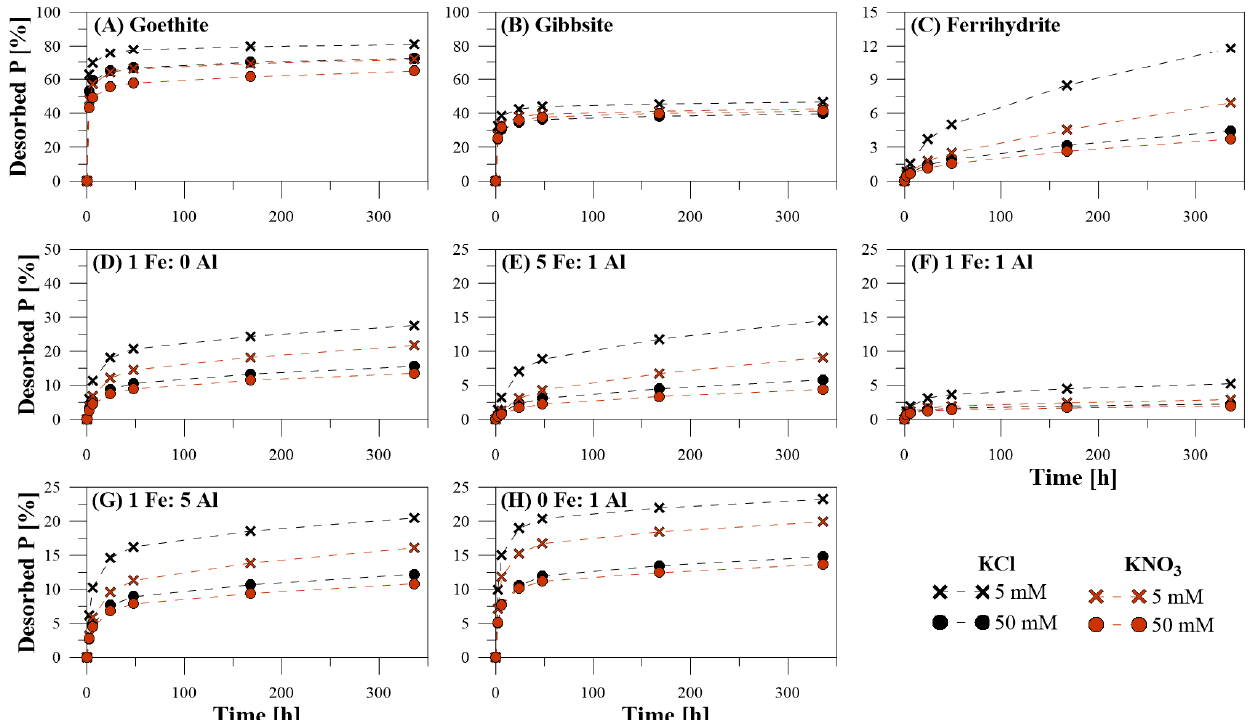
Figure 1. Kinetics of P desorption from ( A ) goethite, ( B ) gibbsite, ( C ) ferrihydrite, ( D ) 1 Fe: 0 Al, ( E ) 5 Fe: 1 Al, ( F ) 1 Fe: 1 Al, ( G ) 1 Fe: 5 Al, ( H ) 0 Fe: 1 Al with KCl and KNO 3 at concentrations of 5 mM and 50 mM.